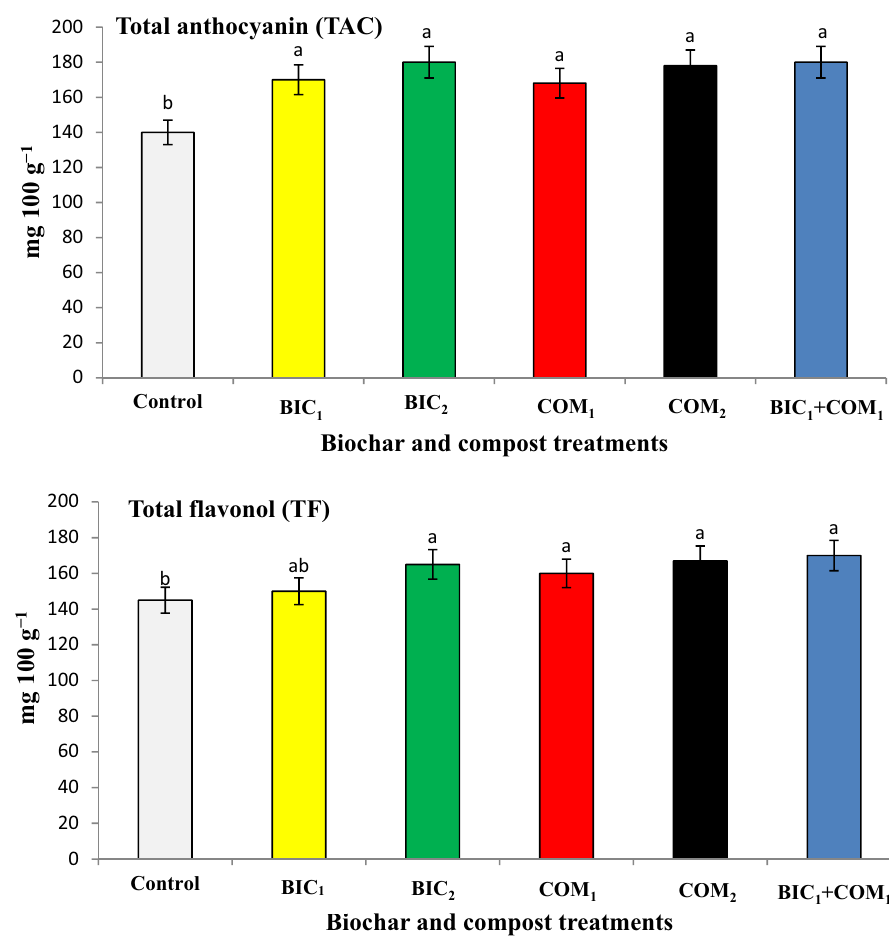
Figure 6. Effect compost and biochar on the total anthocyanin (TAC) and total flavonol (TF). BIC 1 and BIC 2 = biochar at rates of 1 and 2% (w/w), COM 1 and COM 2 = compost at rates of 1 and 2% (w/w), and BIC 1 + COM 1 = mixture of the two amendments at 1% (w/w) of each. Means (± SD, n = 5) denoted by the same letter indicate no significant difference according to Tukey’s multiple range tests at p <